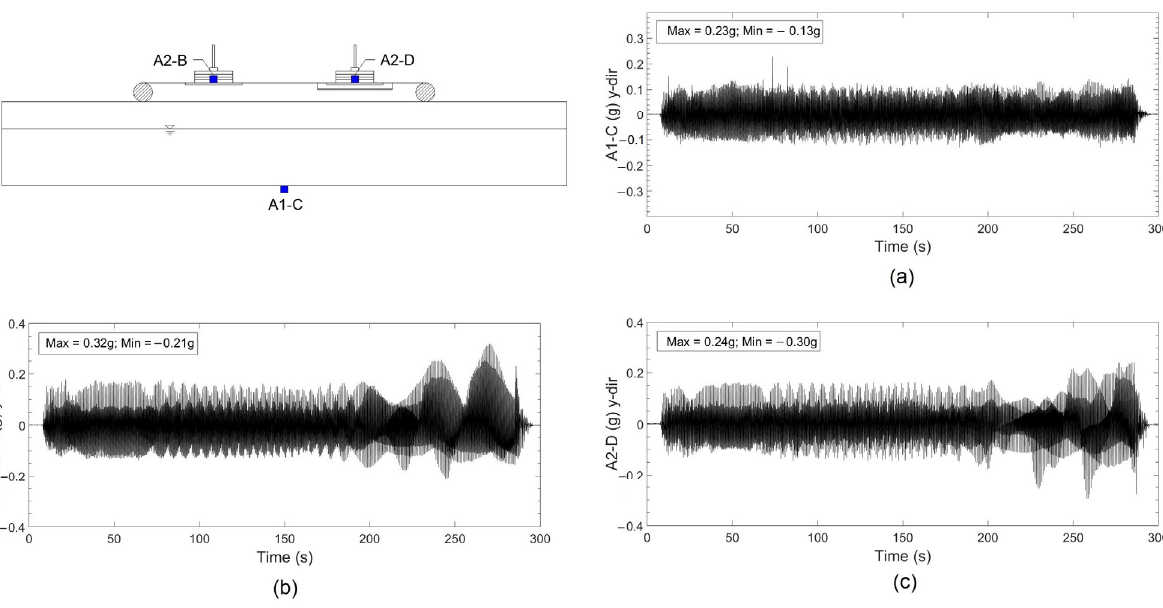
Figure 15. Recorded vertical accelerations: ( a ) A1-C, ( b ) A2-B, and ( c ) A2-D.